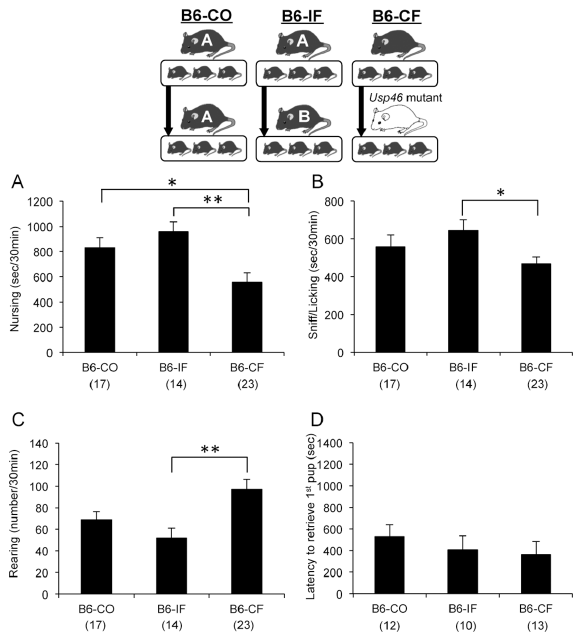
Fig 4. Fostering effects on maternal behavior in B6 mice. B6-CF exhibited a significant reduction in time spent nursing and sniffing/licking pup, and increased the number of instances of rearing. The number of mice used is shown within parentheses. * p < 0.05, ** p < 0.01, one-way ANOVA with Tukey ’ s post hoc